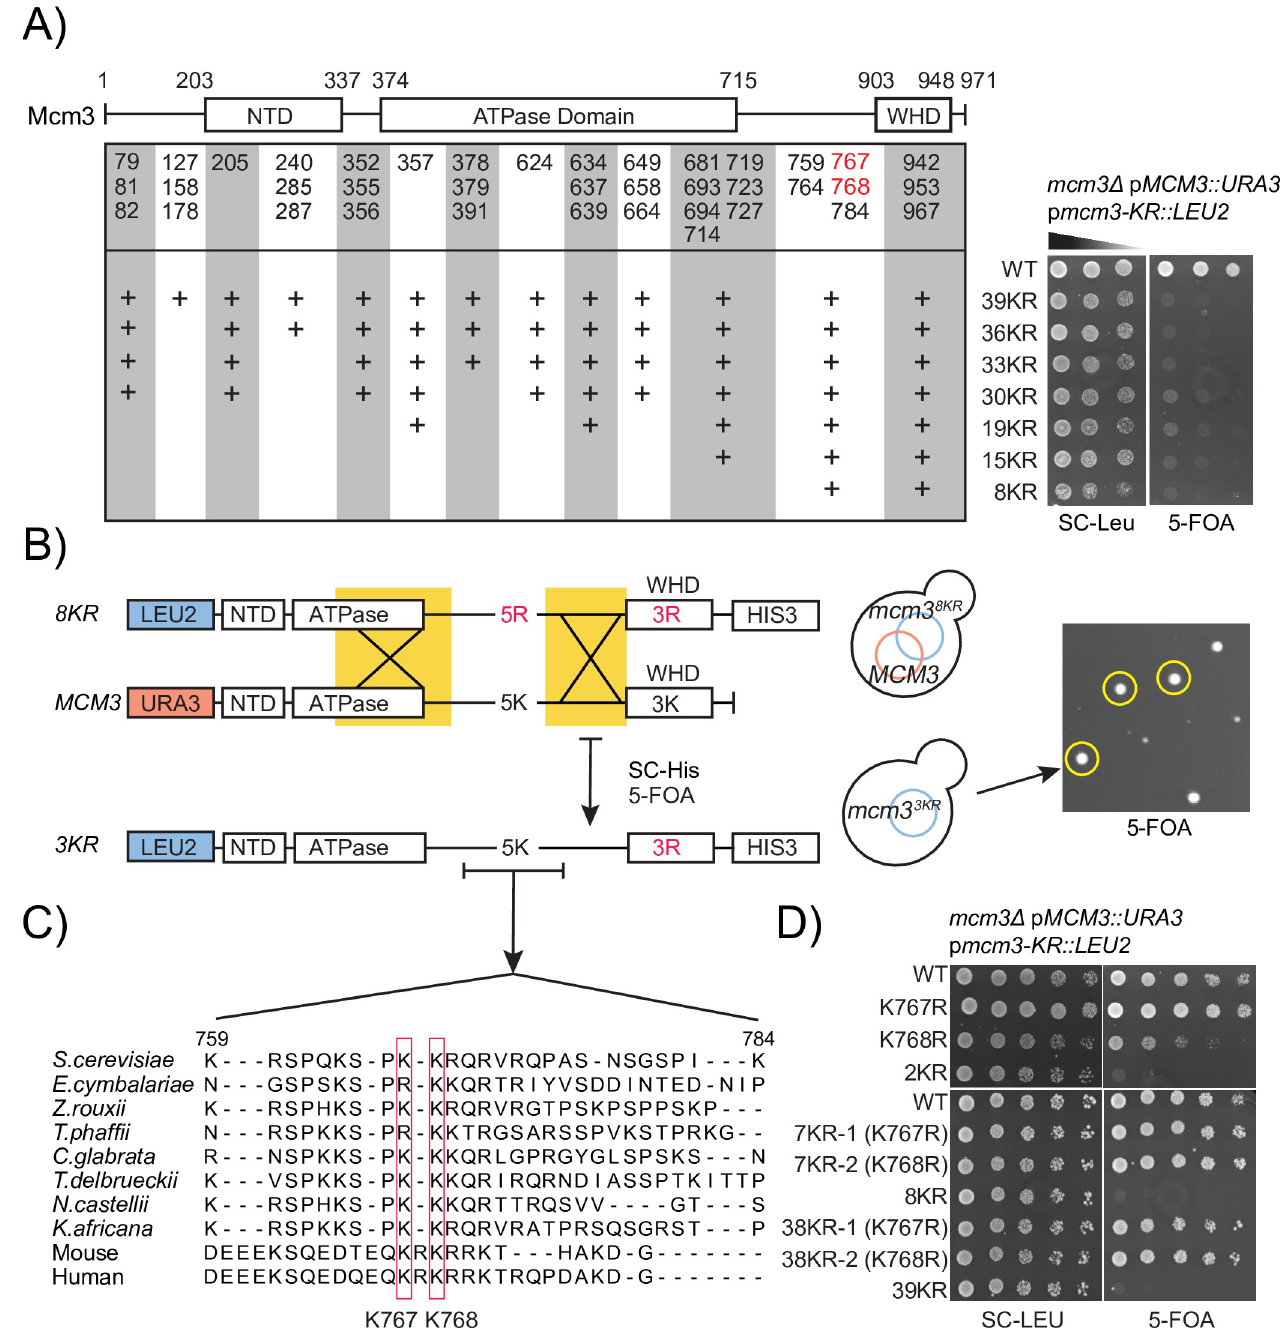
Fig 1. Mcm3 K767/768R mutations impair cell growth. (A) Left: schematic of surface-exposed lysines on Mcm3 (numbers correspond to amino acid positions) that were mutated into arginine, which cannot be modified by SUMO. Right: growth of serial dilutions of the various mcm3-KR mutants on media in which the complementing MCM3 plasmid was retained (SC-Leu) or lost (5-FOA). (B) Gene conversion between the MCM3 and mcm3-8KR mutant plasmids led to faster growing 5-FOA resistant and HIS+ colonies in which the lysines between K759-K784 of Mcm3 were restored to the wild-type sequence. (C) Sequence alignment of fungal, mouse, and human Mcm3 shows that K767 and K768 of S . cerevisiae Mcm3 are conserved. (D) An intact K767 or K768 in Mcm3 is necessary and sufficient to restore growth. Top: effects of mutating K767R, K768R, or both on cell growth on 5-FOA plates. In this case, no other mcm3 mutations exist. Bottom: effects of restoring K767 or K768 in mcm3-8KR and mcm3-39KR backgrounds on cell growth on 5-FOA plates. mcm3-7KR-1 and mcm3-38KR-1 have K767R and K768 , while mcm3-7KR-2 and mcm3-38KR-2 have K767 and K768R .